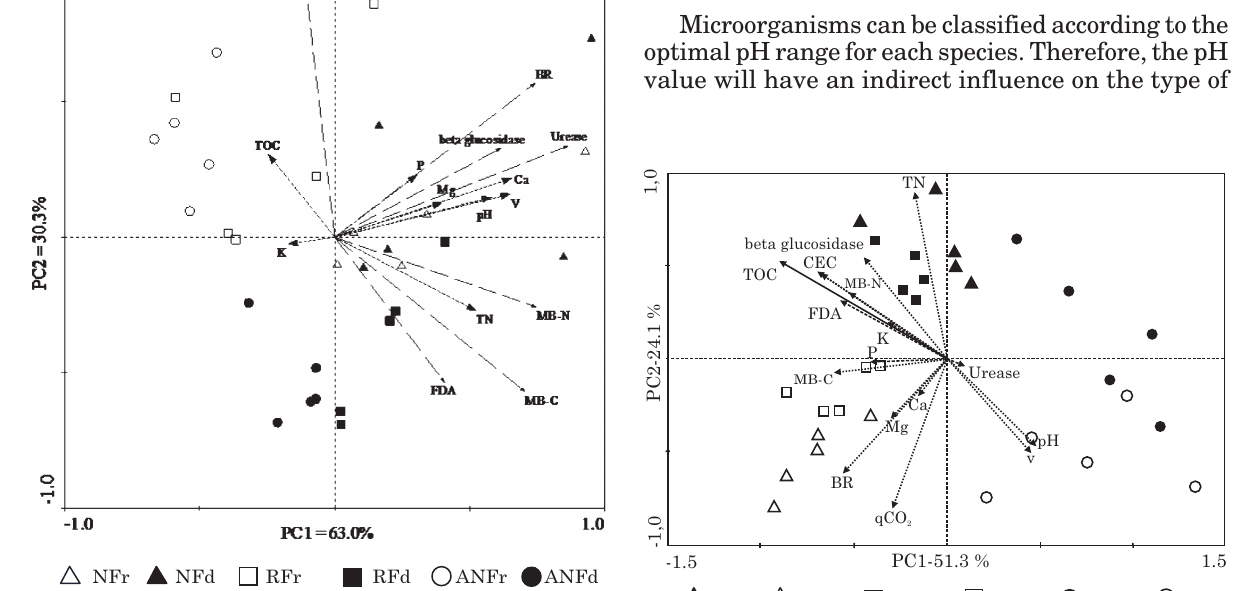
Figure 3. Principal component analysis (PCA) ordination diagram of the PETAR forests, NFr (natural forest, rainy season), NFd (natural forest, dry season), RFr (replanted forest, rainy season), RFd (replanted forest, dry season), ANFr (anthropogenically influenced natural forest, rainy season), and ANFd (anthropogenically influenced natural forest, dry season), as well as soil chemical and biochemical properties.